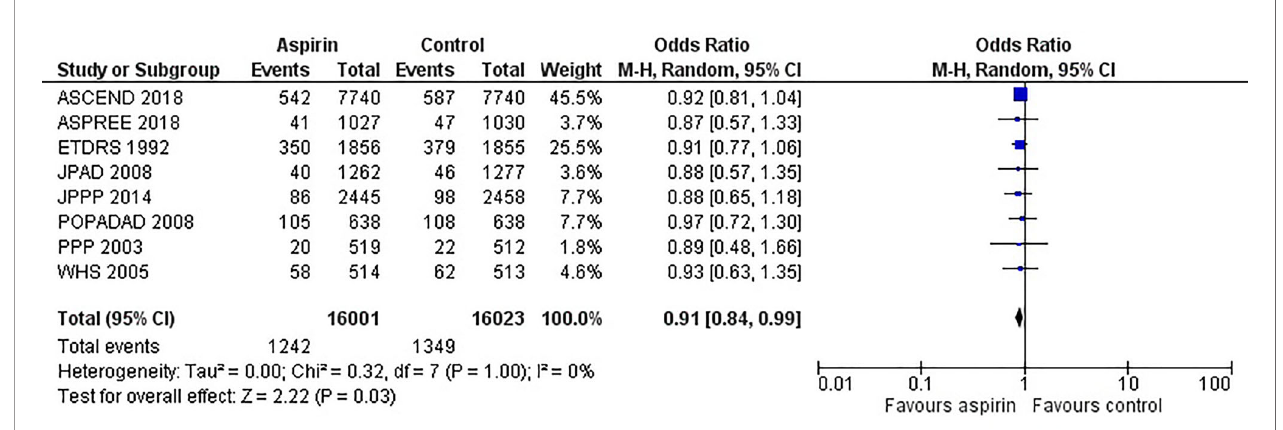
FIGURE 5 | Forest plot for the outcome of composite of major adverse cardiovascular events (MACE) using a random-effects model. Odds ratios and 95% con fi dence intervals are shown. Control: placebo or